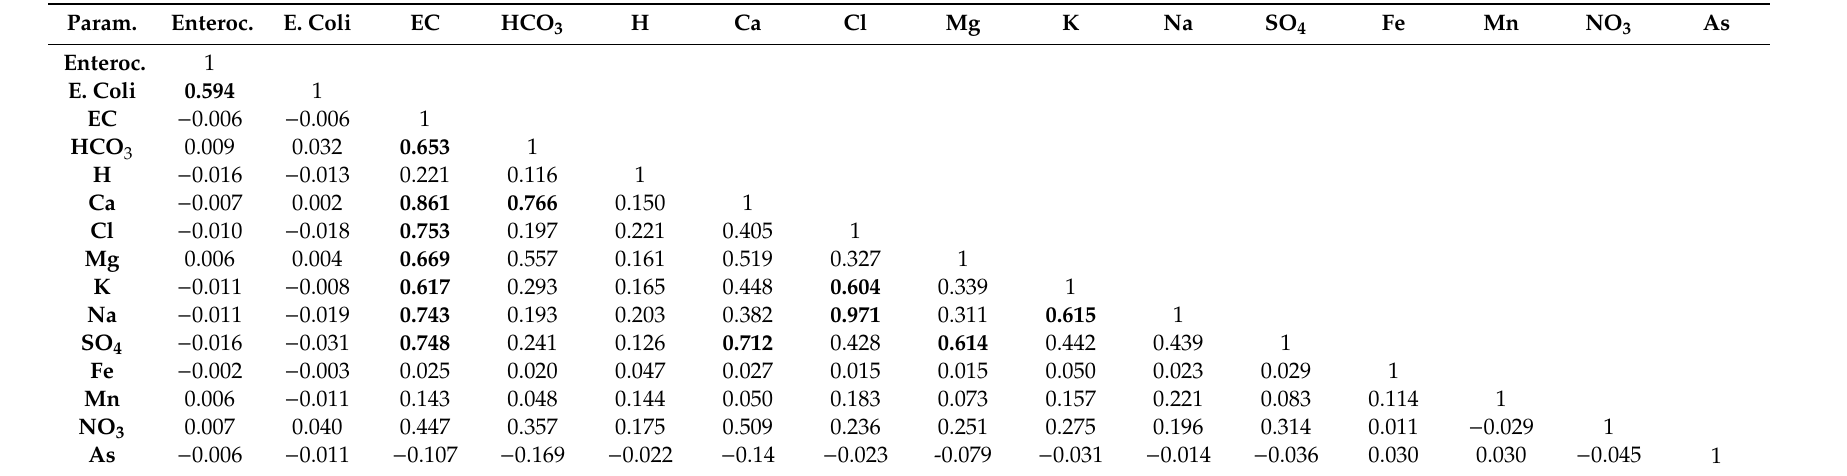
Table 1. Correlation matrix of the 15 physicochemical and biological parameters (5,295